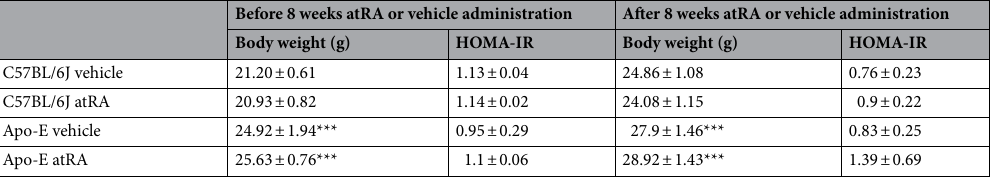
Table 2. Body weight and HOMA-IR before and after 8 weeks of atRA or vehicle treatment. Results are presented as means ± S.E.M. of 5–6 mice per group. The results were analyzed by two ‐ way ANOVA with